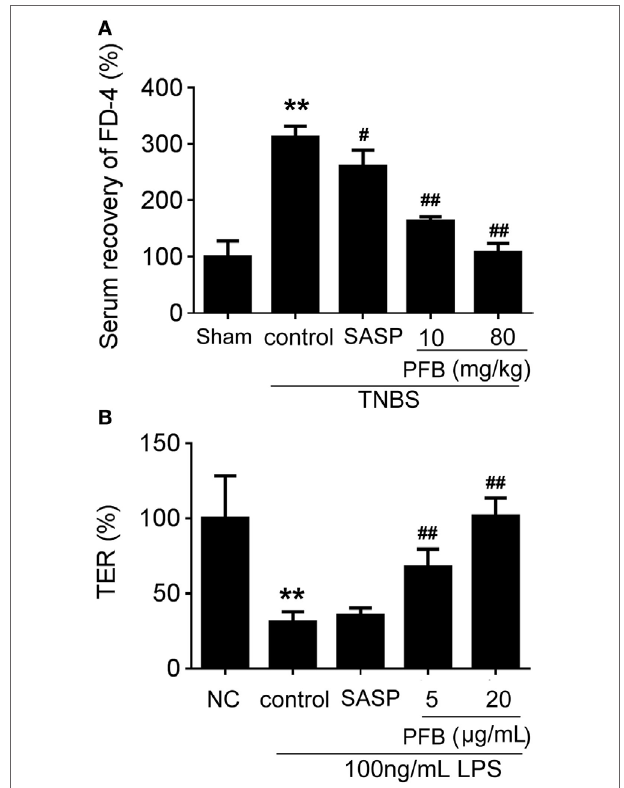
FigUre 4 | Purified fruit bromelain (PFB) reversed the increased intestinal permeability. After 14 days of PFB therapy, the intestinal permeability in each group was examined through testing serum recovery of FD-4 in vivo (a) and transepithelial electrical resistance (TER) in Caco-2 cells (B) ( n = 6). Cells were incubated with 100 ng/mL lipopolysaccharide (LPS) for 24 h in the presence or absence of PFB. Data in the sham group or normal control (NC) cell group are set to a relative value of 100% and expressed as the mean ± SD. Other data are the relative values compared with sham or NC: ** P < 0.01 compared with sham or NC group; ## P < 0.01 compared with TNBS control or LPS control